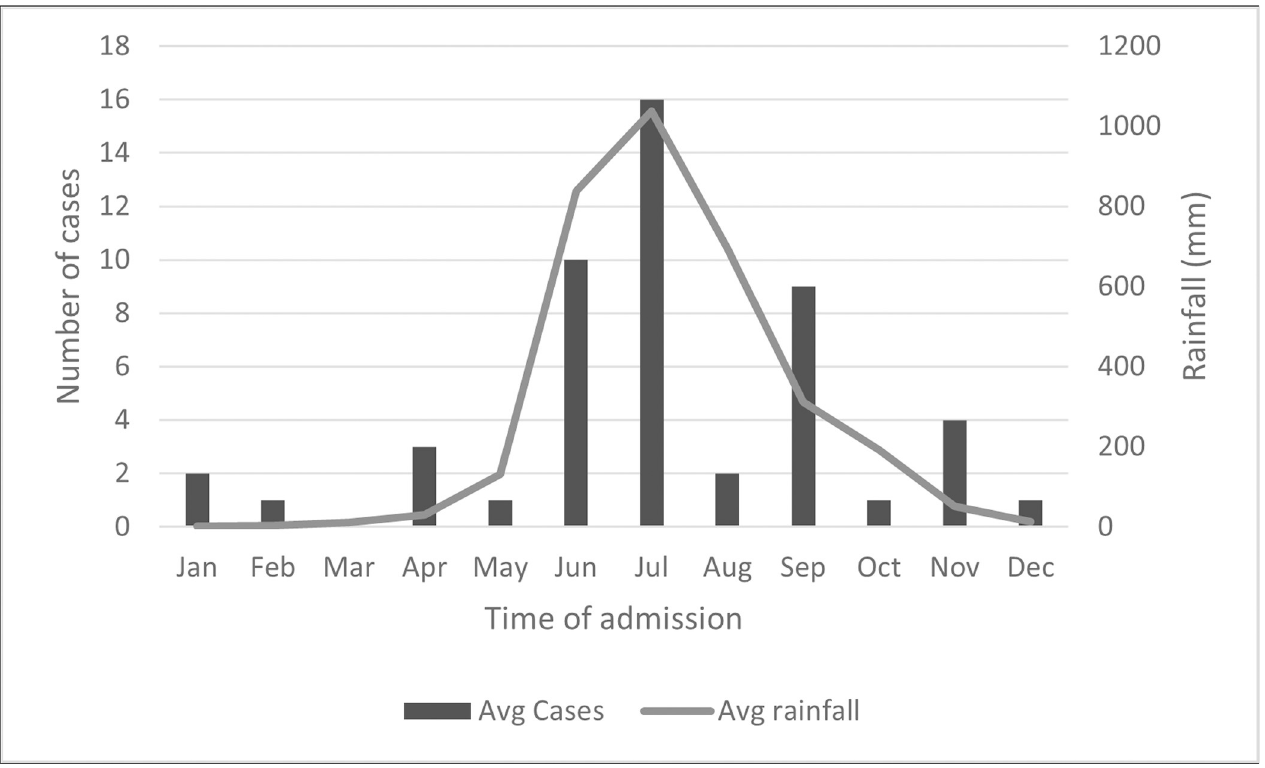
Fig 2. Monthly distribution of average melioidosis cases and rainfall from 2013–2018, Udupi district, Karnataka, India (n = 50).